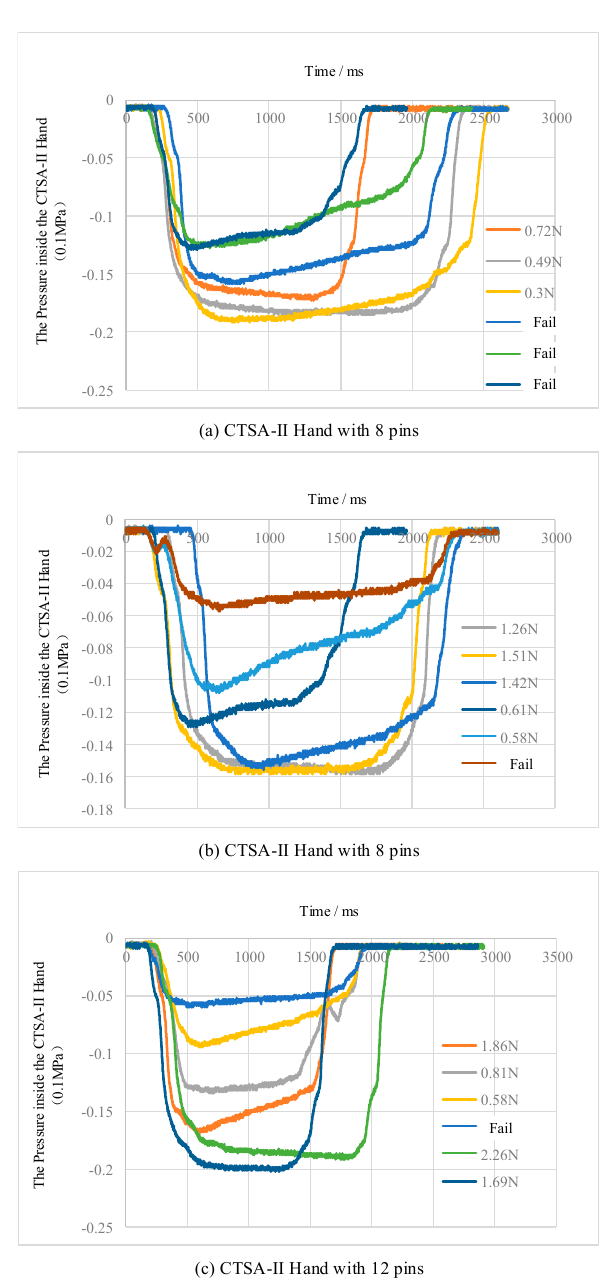
Figure 22. The relationships between the internal pressure and the grasping force.